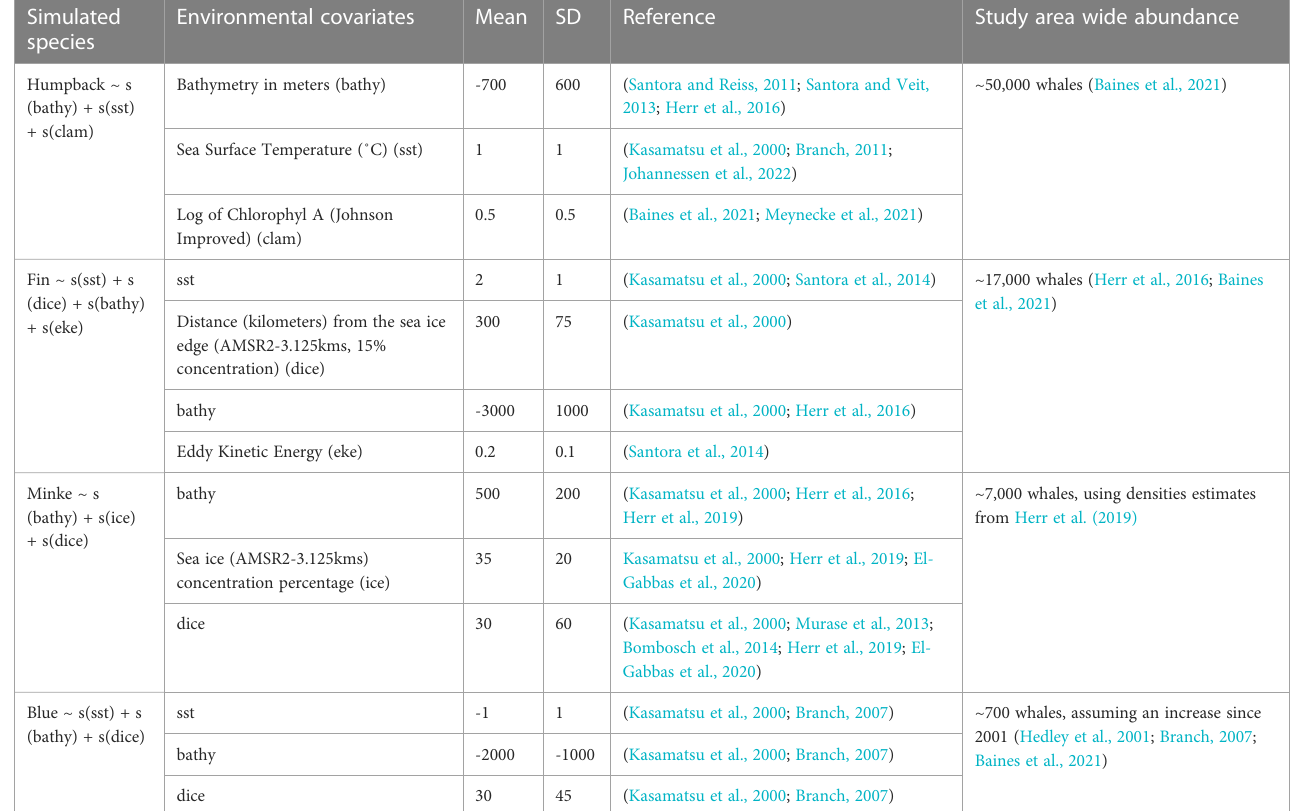
TABLE 1 Literature sort to determine satellite-derived environmental variables used in creating simulated whale fi elds. Simulated Environmental species